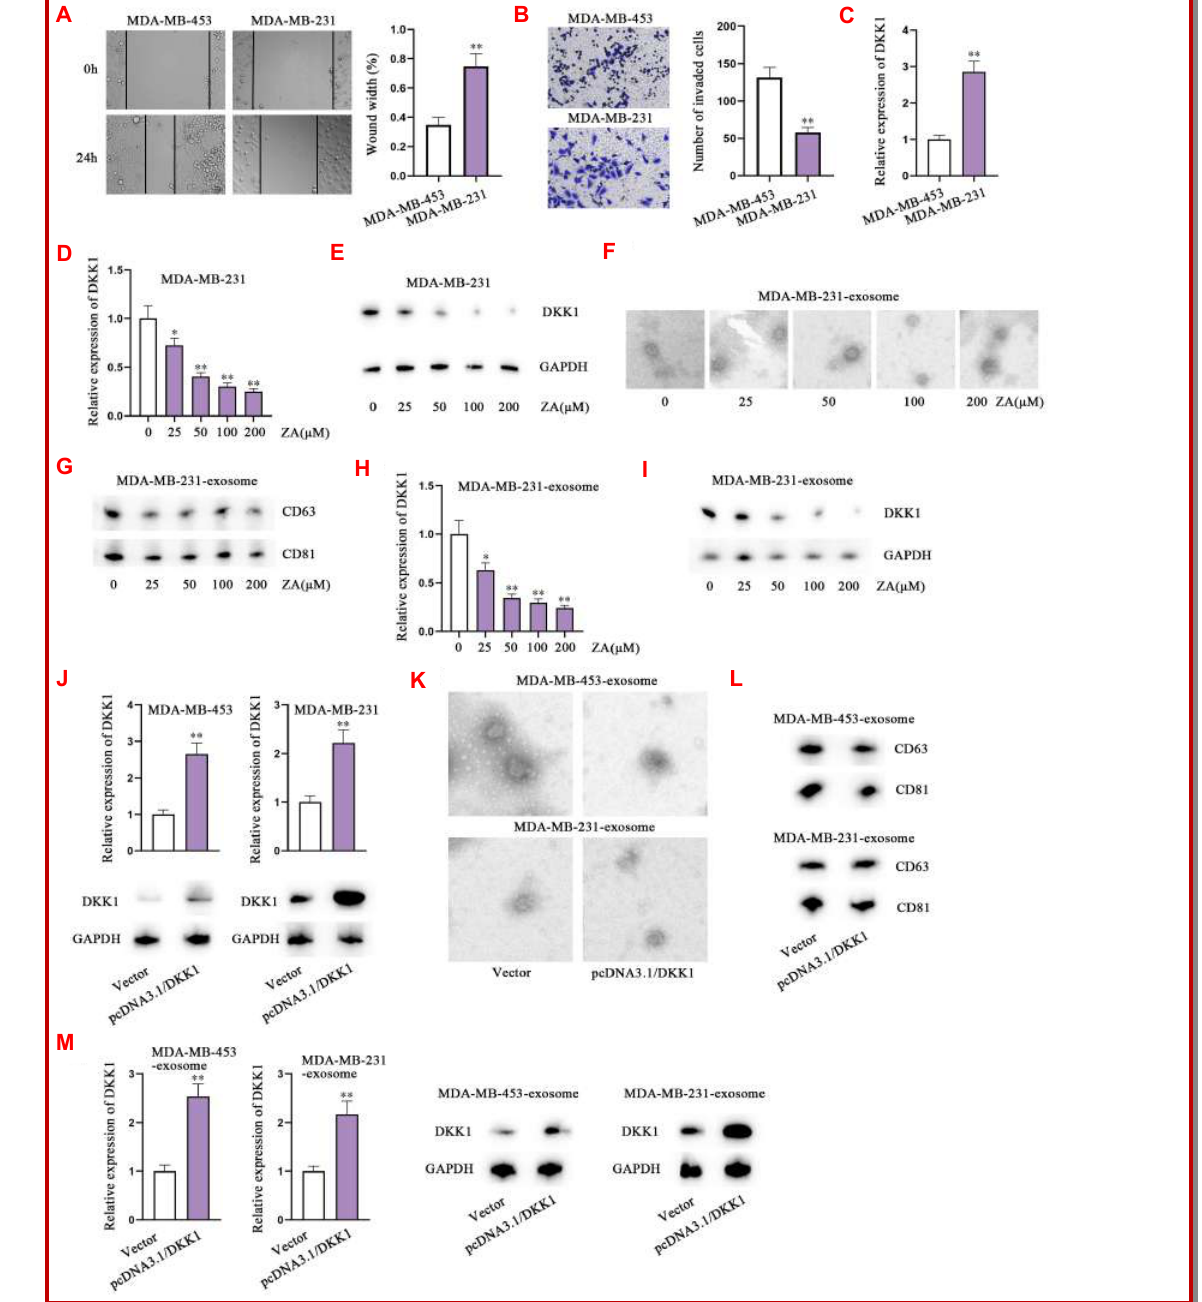
Figure 1: DKK1 was delivered by zoledronic acid-treated breast cancer cells derived exosomes. The migration ability was meas- ured by wound healing assay (A) and transwell assay (B). The expression level of DKK1 in MDA-MB-453 and MDA-MB-231 cells was determined by RT-PCR (C). The gene expression level of DKK1 in MDA-MB-453 cells after treatment of different concentra- tion of zoledronic acid was evaluated by RT-PCR (D). The protein expression level of DKK1 in MDA-MB-453 cells after treatment of different concentration of ZA was evaluated by Western blotting (E). The morphology of extracted exosomes was visualized by TEM (F). The expression level of CD63 and CD81 in extracted exosomes was determined by Western blotting (G). The gene ex- pression level of DKK1 in exosomes derived from zoledronic acid-treated MDA-MB-453 cells was evaluated by RT-PCR (H). The protein expression level of DKK1 in exosomes derived from zoledronic acid-treated MDA-MB-453 cells was evaluated by Western blotting (I). The efficacy of overexpression of DKK1 was evaluated by Western blotting (J). The morphology of extracted exosomes was visualized by TEM (K). The expression level of CD63 and CD81 in extracted exosomes was determined by Western blotting (L). The expression level of DKK1 in exosomes derived from MDA-MB-453 cells and DKK1-overexpressed MDA-MB-453 cells was determined by RT-PCR and Western blotting (M) (p<0.05,